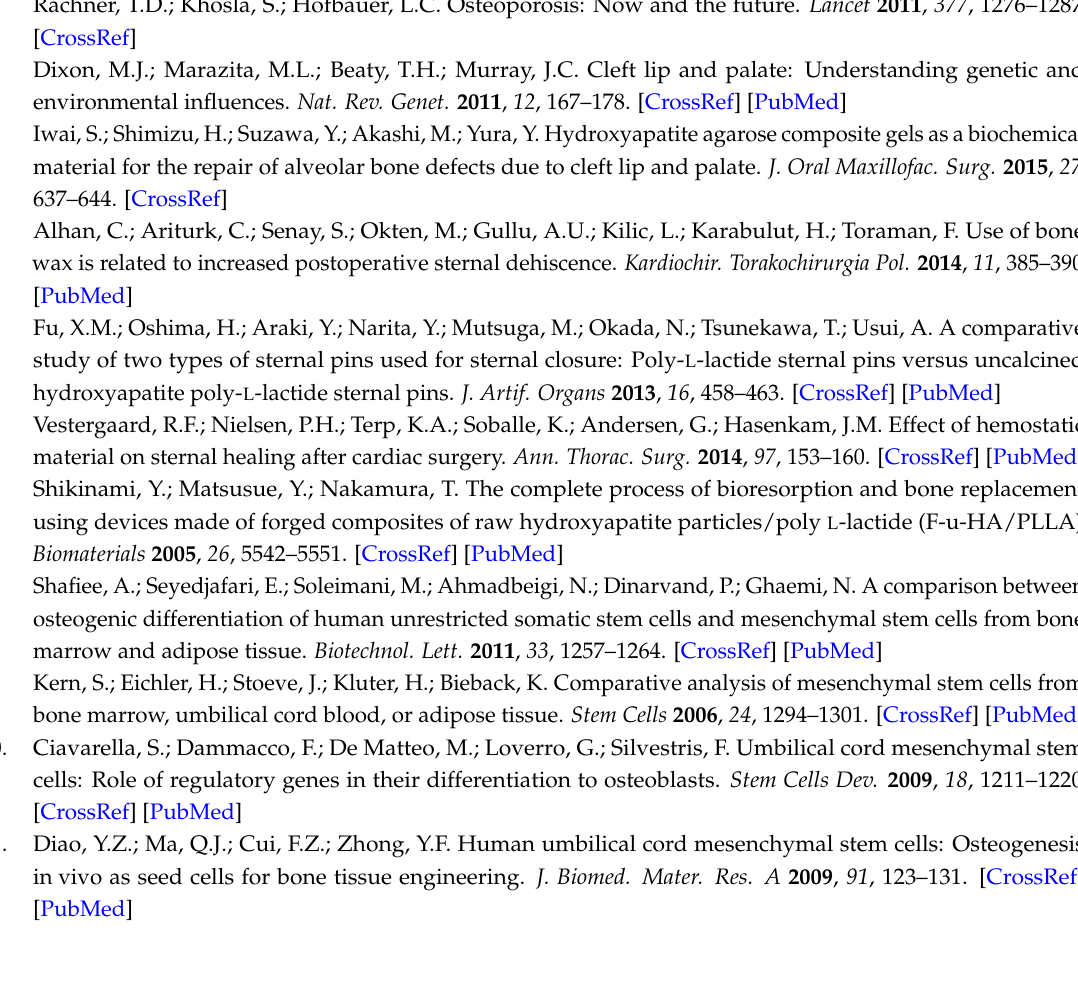
Figure S1: Results of the cell activity assay. The osteogenic differentiation of cells was determined by the ALP assay at Day 7. The values were normalized to that of the Blank (value of no peptide = 1.0). (a) OBs; (b) UC-MSCs. All experiments were performed in triplicate. * Denotes statistical significance compared to Blank (no peptide), p < 0.05, Student’s t -test. ** Denotes statistical significance compared to Blank, p < 0.01, Student’s t -test. We would like to thank Editage for English language